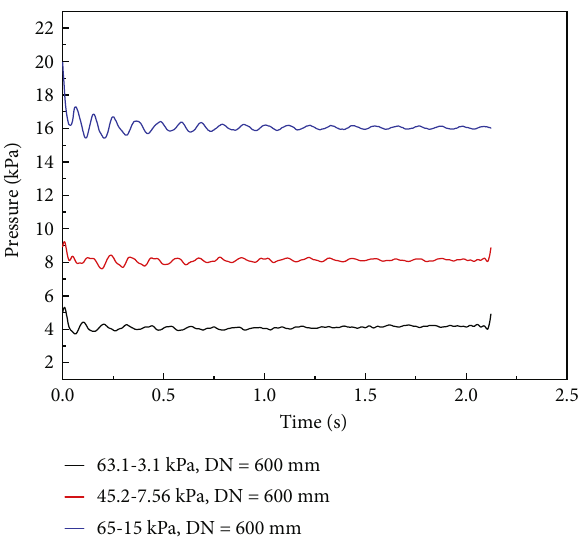
Figure 13: Rapid decompression and balancing process when DN = 600mm .